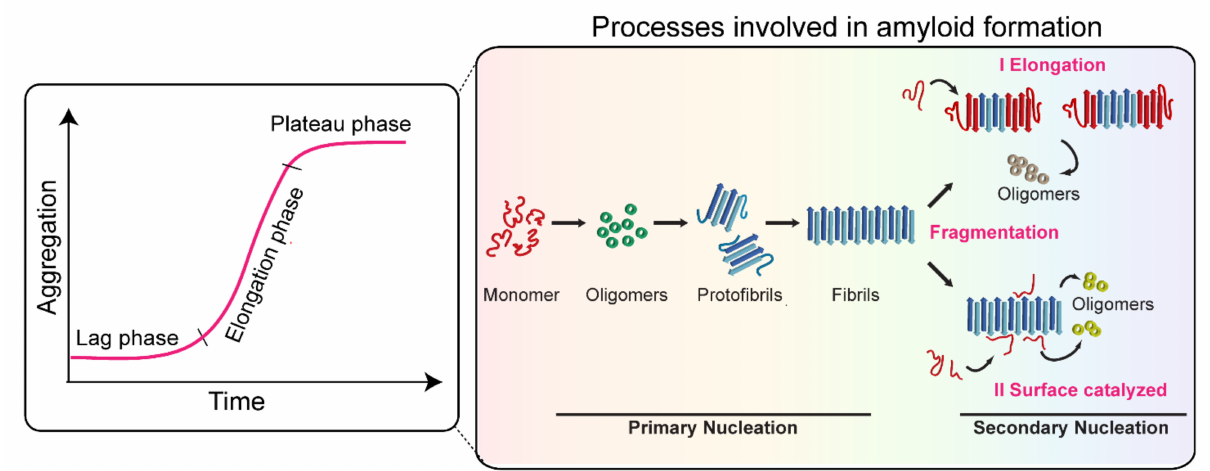
Figure 2. Processes involved in α -Syn aggregation. The amyloid growth kinetics of α -Syn follow three different phases, (i) the lag phase, (ii) the elongation phase, and (iii) the stationary/plateau phase. Primary nucleation, secondary nucleation, fragmentation, and elongation processes are active through all the phases of the growth curve, however, at different